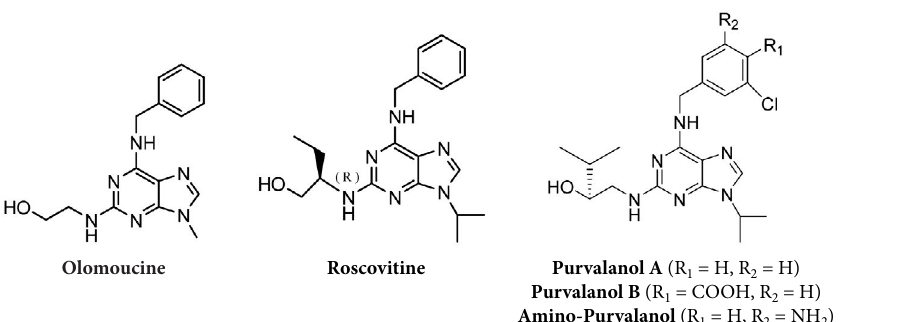
Figure 1. Structures of olomoucine, roscovitine, purvalanol A, B and amino-purvalanol